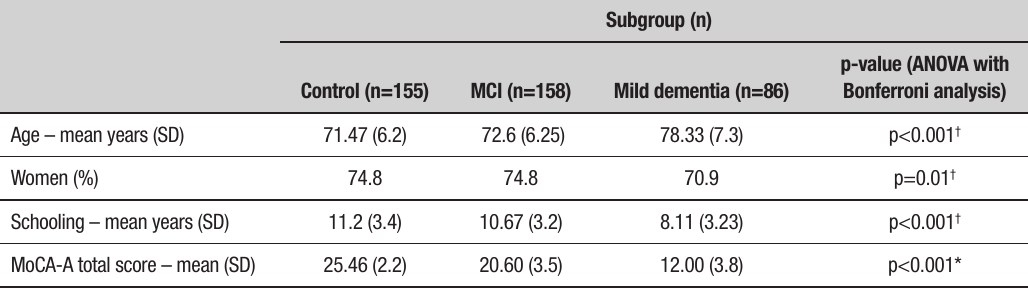
Table 2. Demographic characteristics and MoCA performance by subgroups.